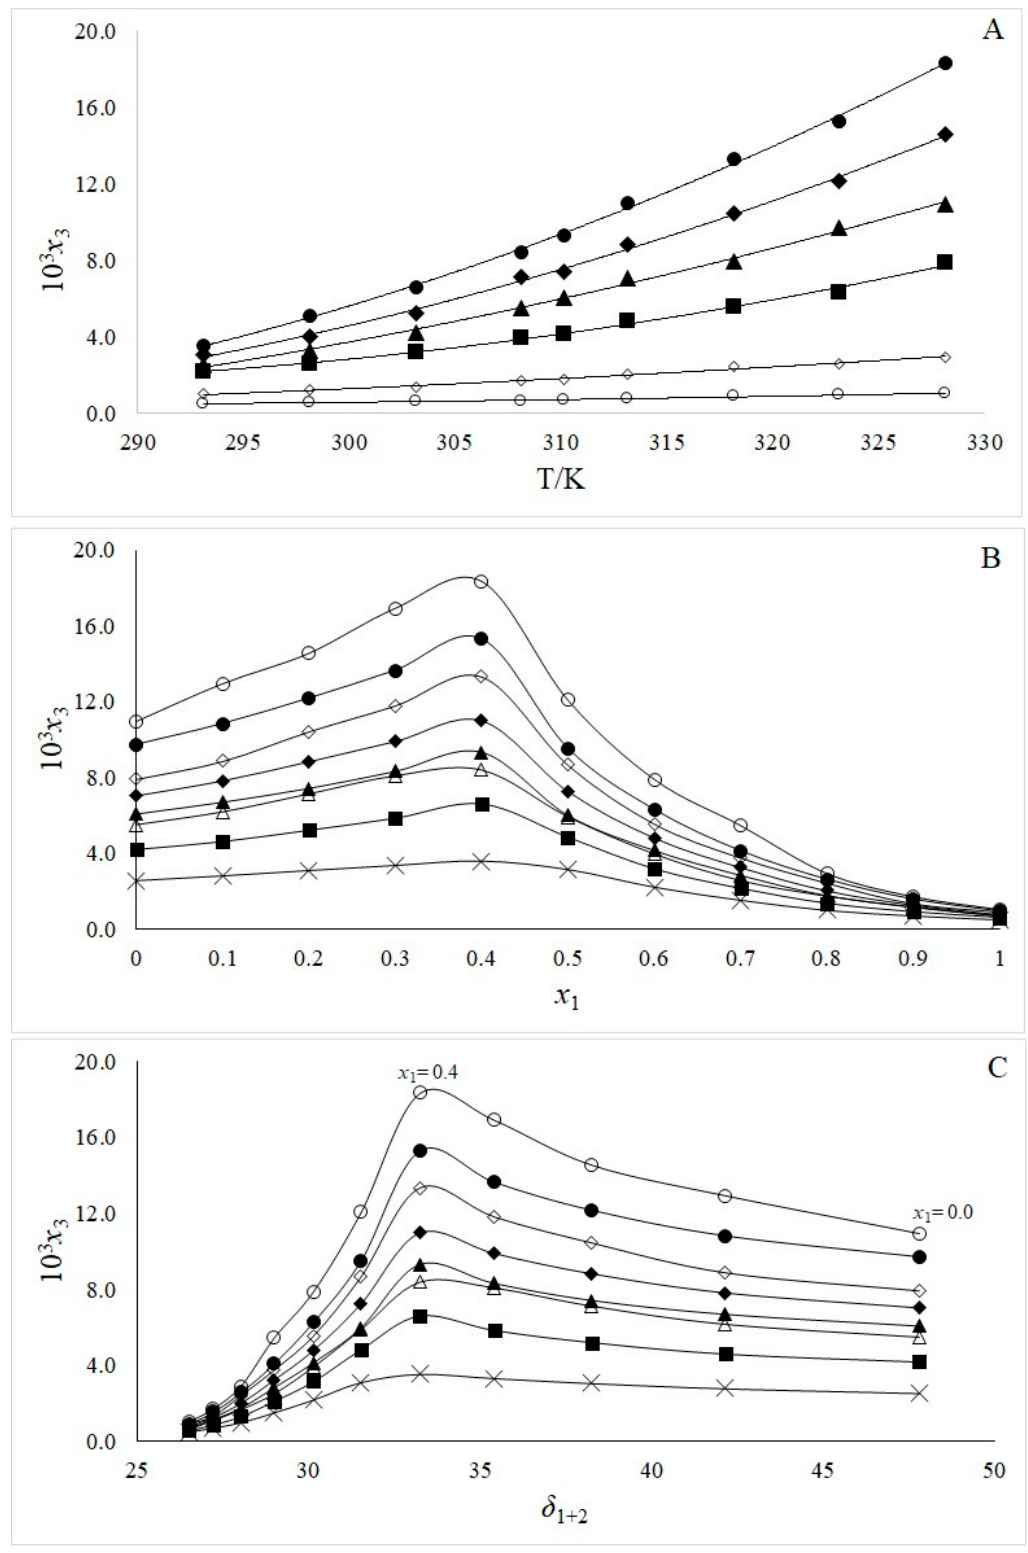
Figure 2. Experimental solubility of amygdalin (3) in mole fraction (10 3 x 3 ) as a function of temperature ( A ); as a function of composition of solvent mixtures ( B ); and as a function of Hildebrand solubility parameter δ 1 + 2 of the [ethanol (1) + water (2)] mixtures ( C ). For A, ○ : EtOH; ◊ : x 1 = 0.8; ■ : x 1 = 0.6; ▲ : water; ♦ : x 1 = 0.2; and ● : x 1 = 0.4, and for B and C, x: 293.15 K; □ : 298.15 K; ■ : 303.15; ∆ : 308.15; ▲ : 310.15 K; ♦ : 313.15 K; ◊ : 318.15 K; ● : 323.15 K; and ○ : 328.15 K.